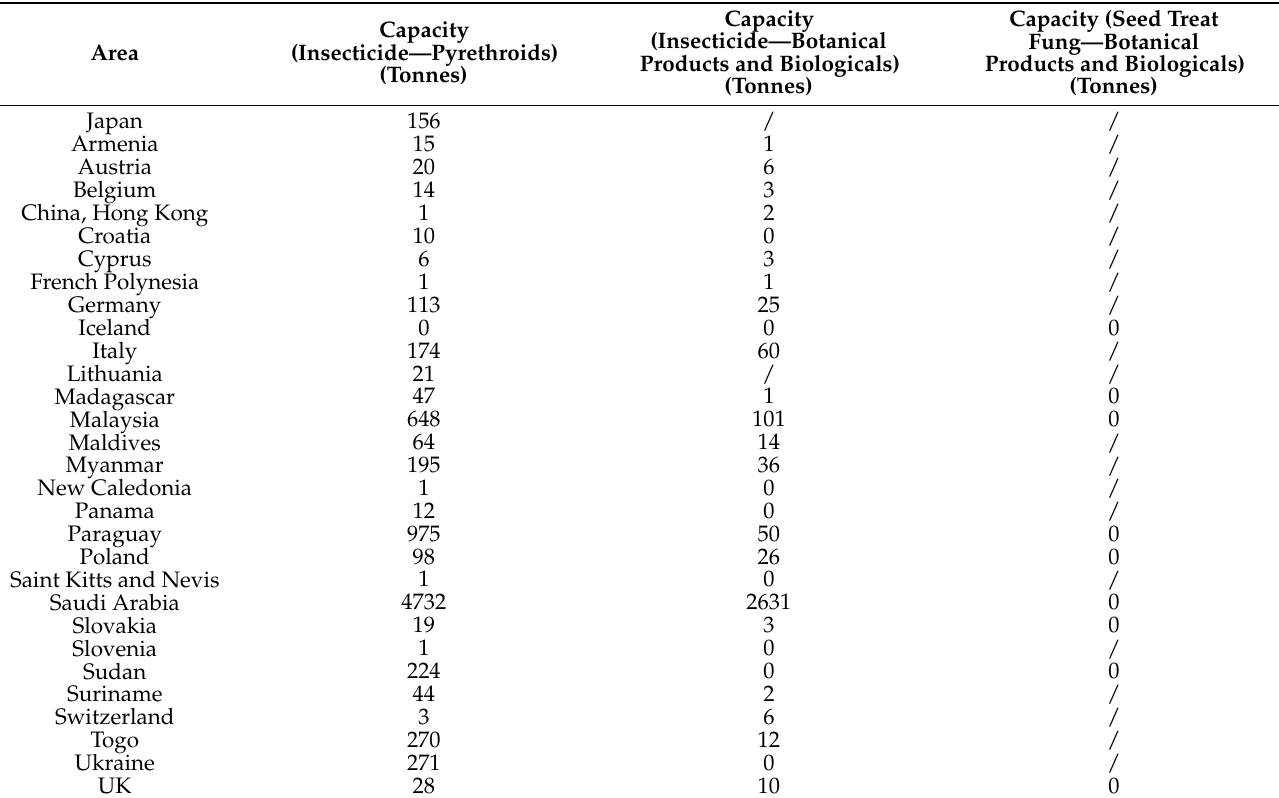
Table 1. Botanical pesticides used worldwide in 2022. Capacity (Insecticide—Pyrethroids) (Tonnes)